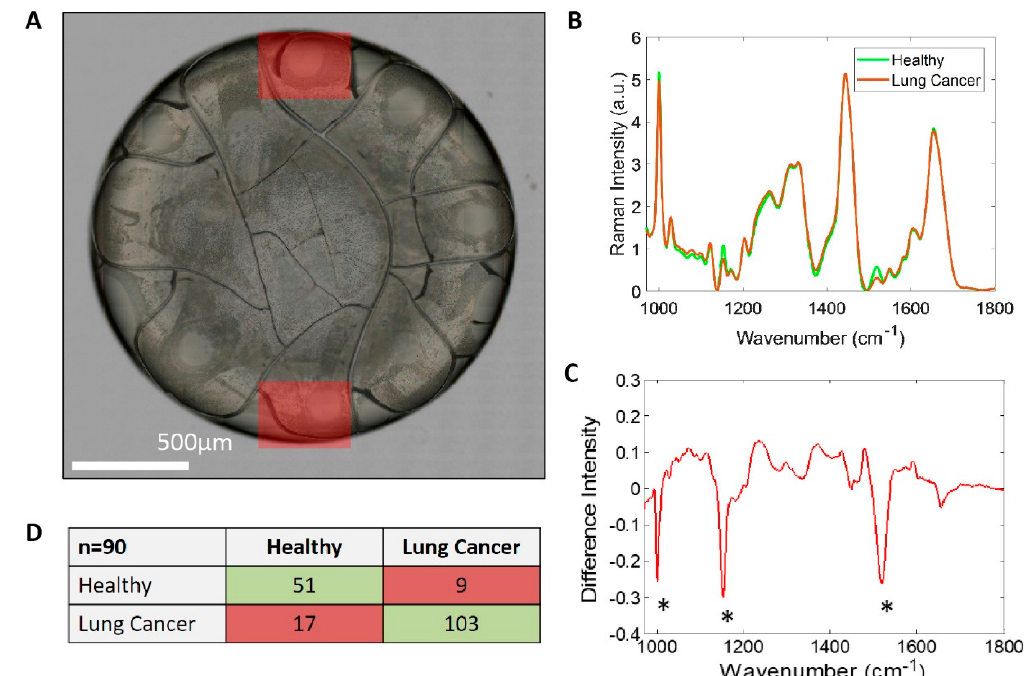
Figure 6. ( A ): 50 × white light image of a 1 µ L drop of blood plasma deposited on polished stainless steel, red regions indicating approximate position and area of Raman maps. ( B ): Combined map average Raman spectra of healthy control blood plasma drops (green) and lung cancer (red). ( C ): Control subtracted lung Raman spectrum. ( D ) Confusion matrix demonstrating the performance of the cross-validated PCA-LDA model for pathology classification. In benign controls (Healthy) 51 out of 60 measurements were predicted correctly (green); whereas only nine were false positives (red). In LC patients, 103 out of 130 measurements were predicted correctly (green) whereas only 17 measurements were mispredicted (red).